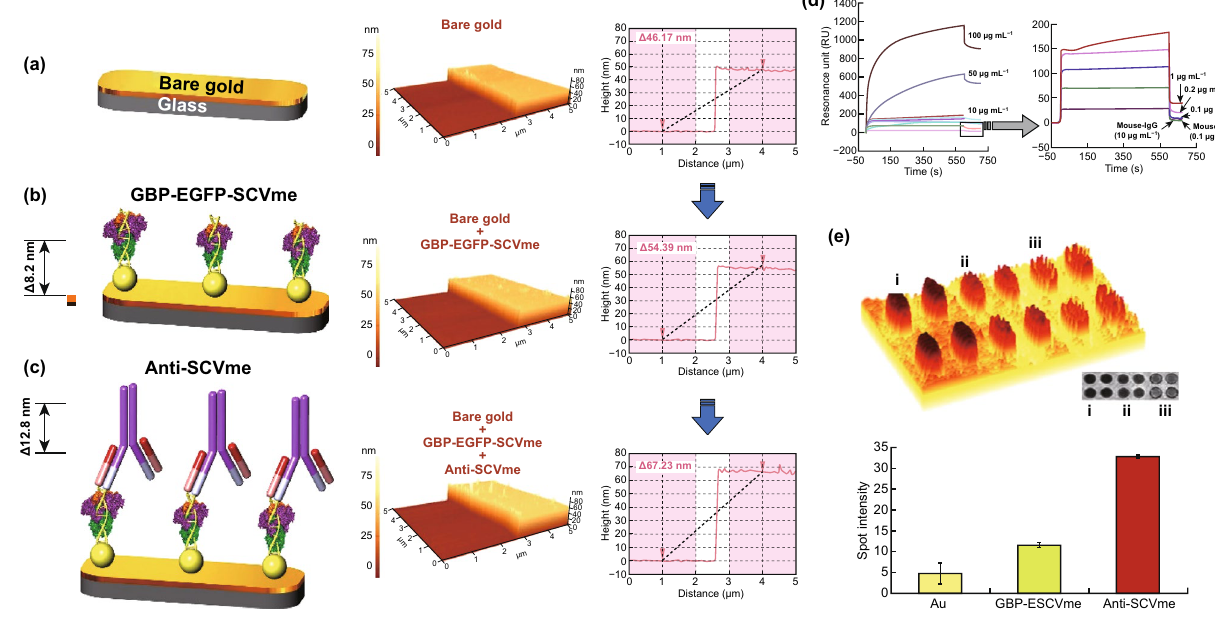
Fig. 11 AFM pictures of the consecutive binding of anti‑SCVme on the gold‑micropatterned surface and GBP‑E‑SCVme. a Bare Au surface, b immobilizing of the GBP‑E‑SCVme fusion proteins onto the gold surface, and c consequent connection of the anti‑SCVme antibodies on the GBP‑E‑SCVme layer. Left, schematic of consecutive binding of GBP‑E‑SCVme and anti‑SCVme on the gold micropatterns; middle, three‑ dimensional topological images; right, the cross‑sectional contours of samples a – c , sequentially (these are average height differences of the individual scan lines from each area). d SPR sensorgrams for (1) sensitive and (2) selective recognition of anti‑SCVme utilizing the GBP‑E‑ SCVme‑imbedded gold sensor chip at different concentrations (0.1, 1, 10, 50, and 100 µg mL −1 ) of anti‑SCVme and (1 and 10 µg mL −1 ) of mouse IgG as negative controls. SPRi analysis of the sequential binding of GBP‑E‑SCVme and anti‑SCVme onto gold micropatterns composed of 50‑nm‑diameter circles. e Three‑dimensional and two‑dimensional (inset) images of bare gold micropatterns as controls (sample (i)); bind‑ ing of GBP‑E‑SCVme fusion proteins onto the gold patterns (sample (ii)); and successive binding of GBP‑E‑SCVme and anti‑SCVme onto the gold patterns (sample (iii)). Spot intensities of the three samples shown in scanned images were measured through the gold circle micropatterns. Adapted from Ref.